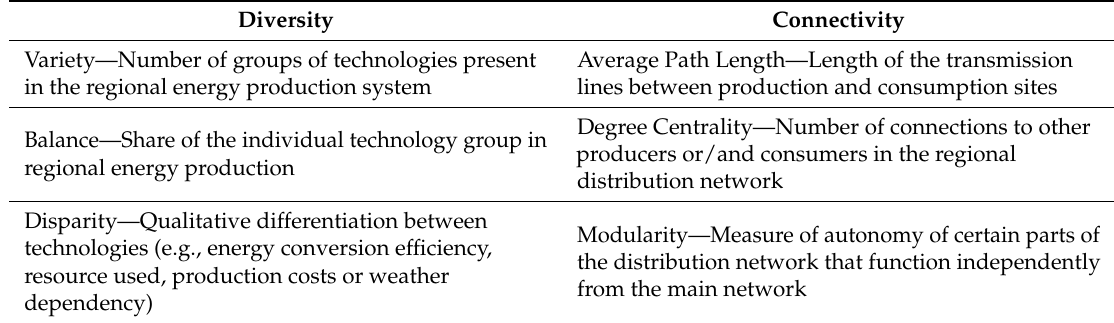
Table 2. Indicators for the technical subsystem (based on